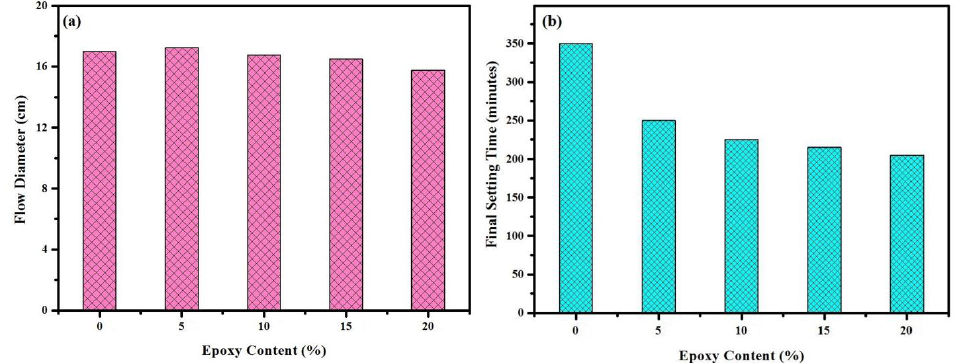
Figure 5. ( a ) Flow diameter and ( b ) final sitting time of all tested specimens.